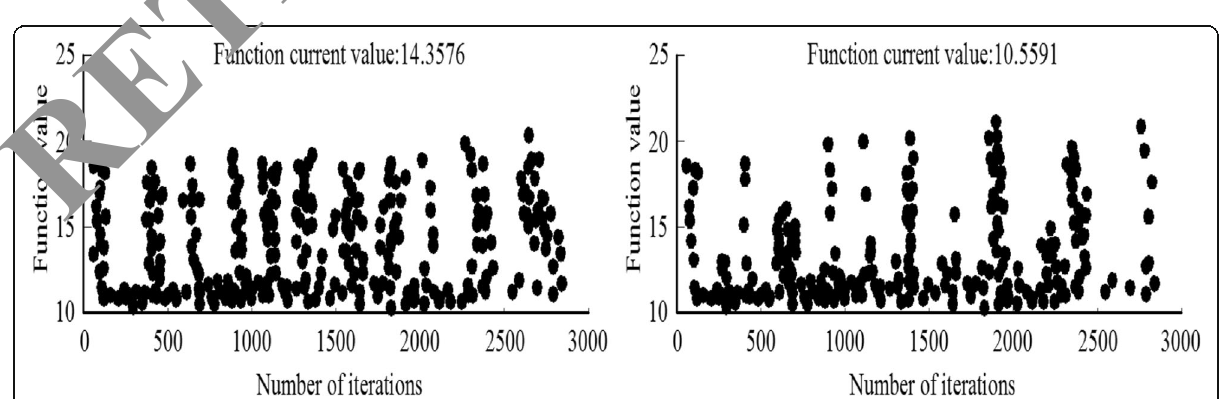
Fig. 3 Based on the annealing algorithm, the implementation of the judicial execution plan in the administrative law system